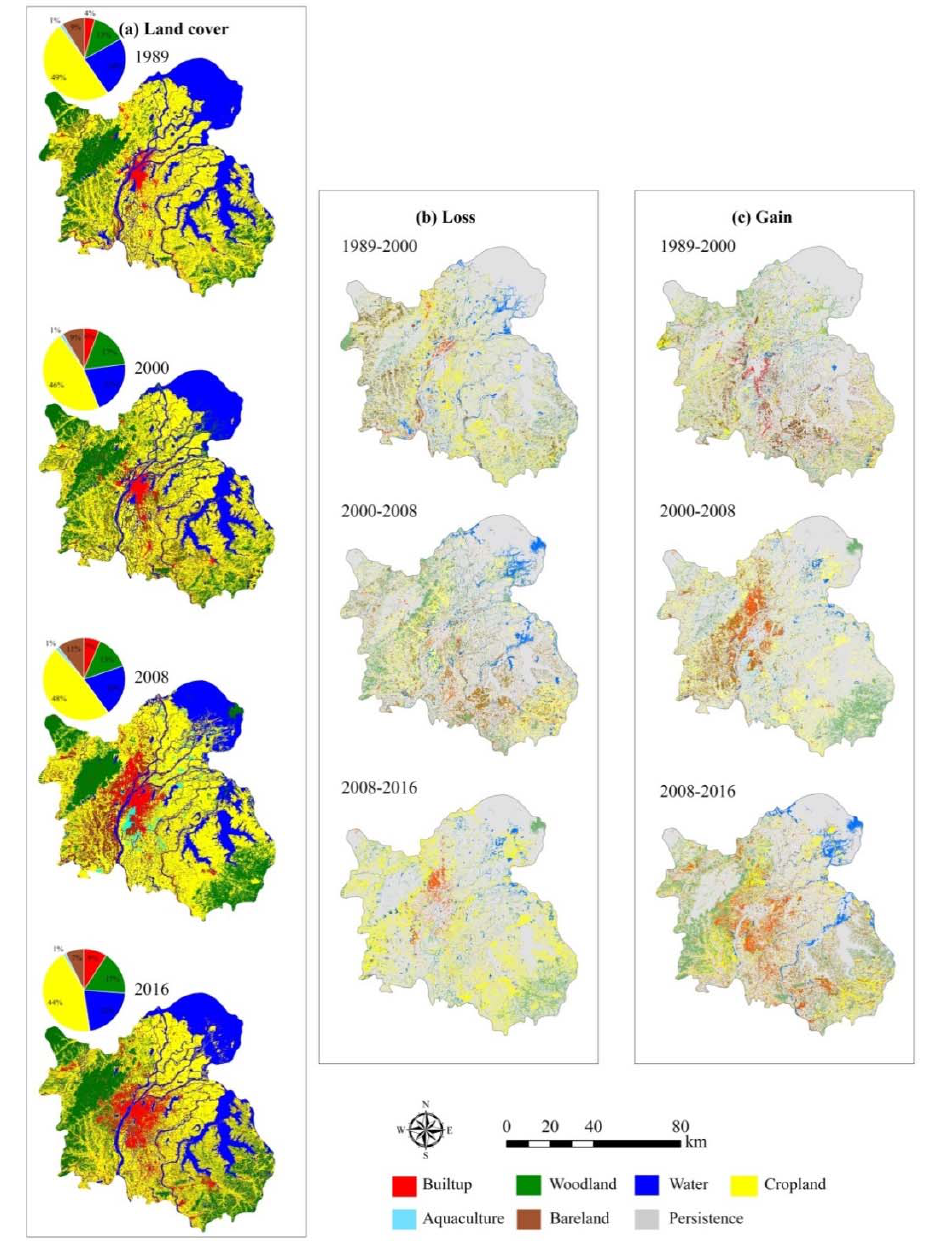
Figure 4. Maps of ( a ) land categories ( b ) losses and ( c ) gains in